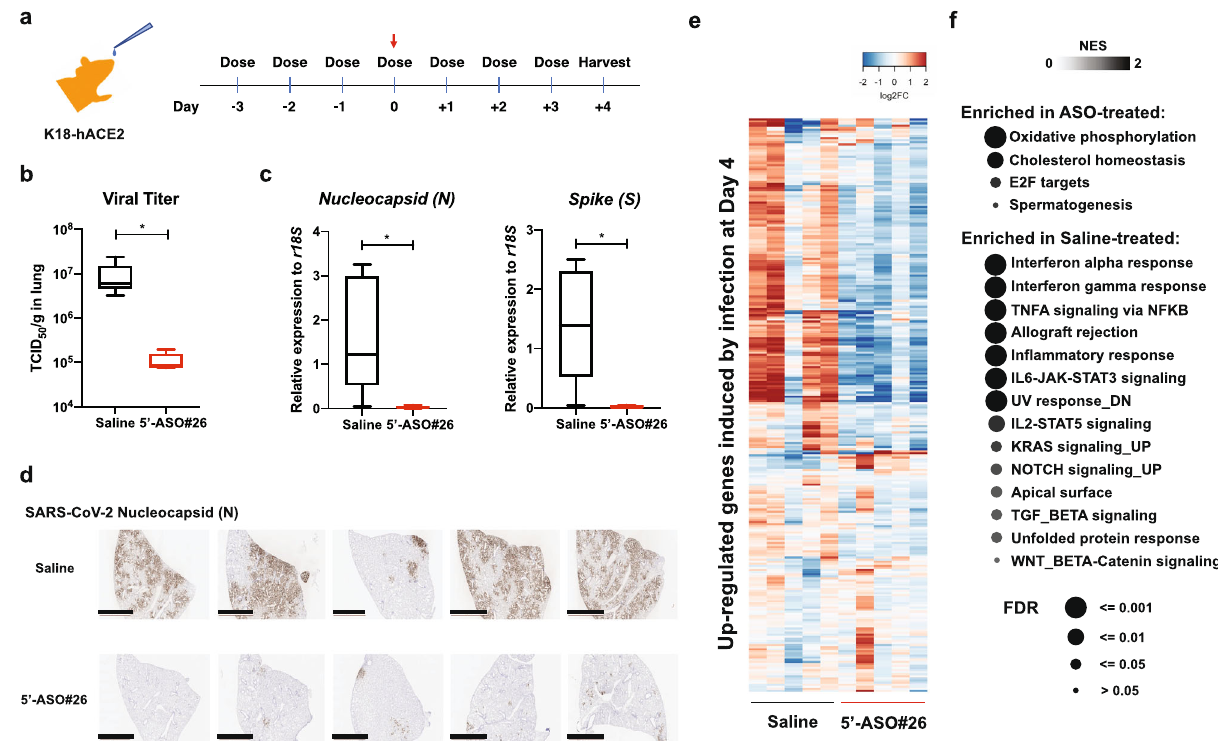
Fig. 4 | Once-daily treatment of 5 ′ -ASO#26 represses the generation of infec- tious virus in mice. a Treatment course of once-daily 5 ’ -ASO#26 administration. The red arrow indicates the inoculation of 1×10 4 TCID50 SARS-CoV-2 intranasally in mice. Mice were treated once-daily with saline (vehicle) or 400 µ g LNA ASO (dissolved in saline). Treatment on the day of infection was carried out at 6 hpi. b The viral burden in lungs of mice treated with Saline ( N =5) or LNA ASO ( N =5) was measured by TCID 50 assay using lung homogenates. * P =0.0427. Center line, median;boxlimits, upperand lowerquartiles;plotlimits, maximum and minimum in the boxplot. c The levels of viral RNAs encoding Nucleocapsid protein (N) (* P =0.0246)andSpike(S)(* P =0.0121)weremeasuredinmouselungsbyRT-qPCR ( N =5).For b and c , center line, median; box limits, upper and lower quartiles;